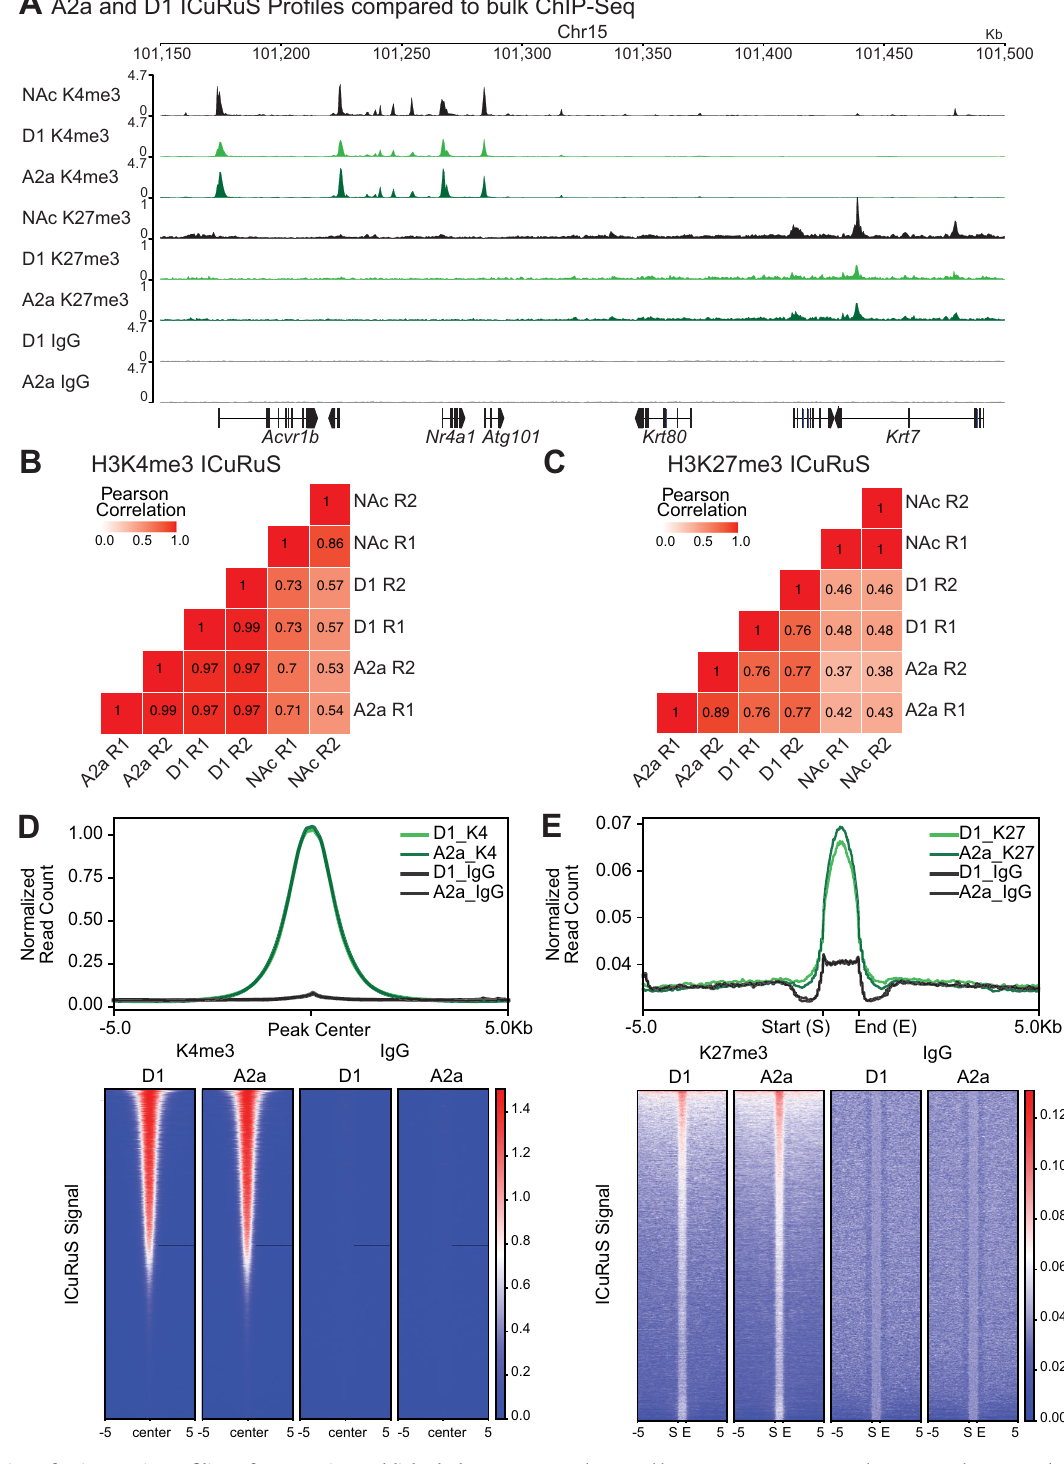
Fig. 2 | Validation of epigenomic pro fi ling of MSNs using published ChIP-Seq data. A Representative genome browser views of different pro fi ling methods and cell-types. Nucleus accumbens (NAc) bulk ChIP-seq data come from 28 . Signal is normalized to total mapped reads: Count Per Million (CPM). B H3K4me3 and C ) H3K27me3 heatmap showing Pearson ’ s correlation coef fi cients among NAc ChIP- seq, D1 CnR, and A2a CnR. Two replicates are shown for each dataset. The corre- lation coef fi cients were calculated by dividing the genome into 1kb bins and countingreadsineachbin. D EnrichmentofA2aandD1CnRH3K4me3orIgGsignal centered on peaks called from NAc H3K4me3 ChIP-seq by MACS2. Top 20,000